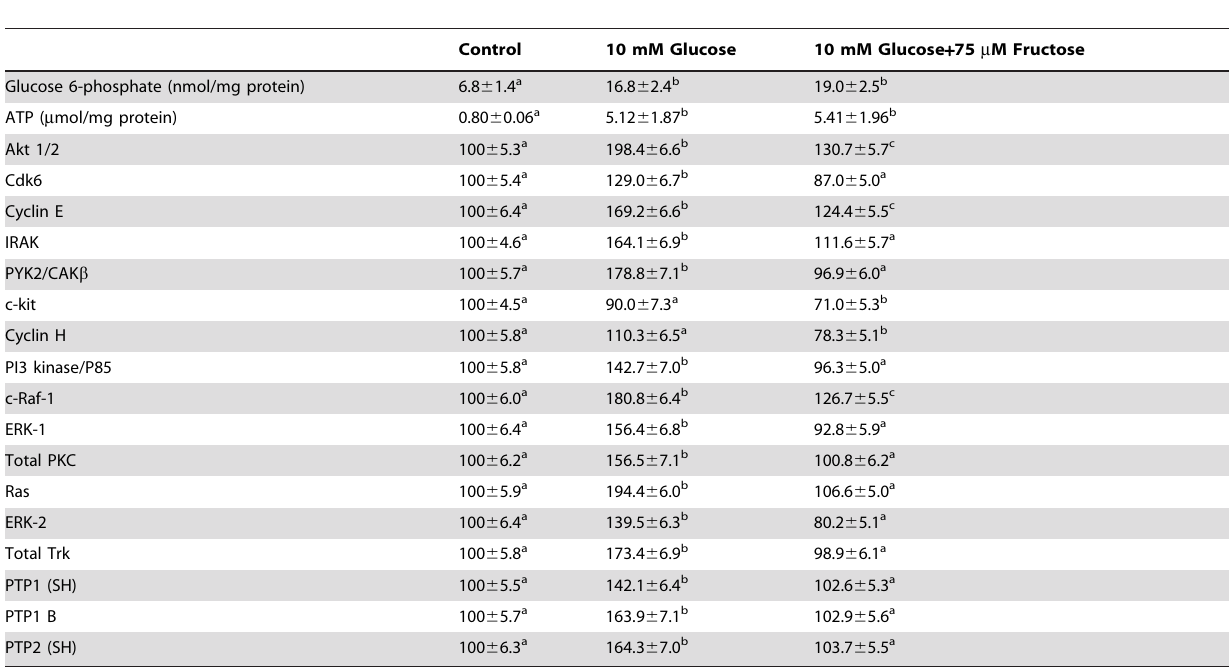
Table 5. Intracellular glucose 6-phosphate and ATP levels and relative increase in serine phosphorylation levels of selected proteins from cultured skeletal muscle cells incubated in the presence or absence of glucose or